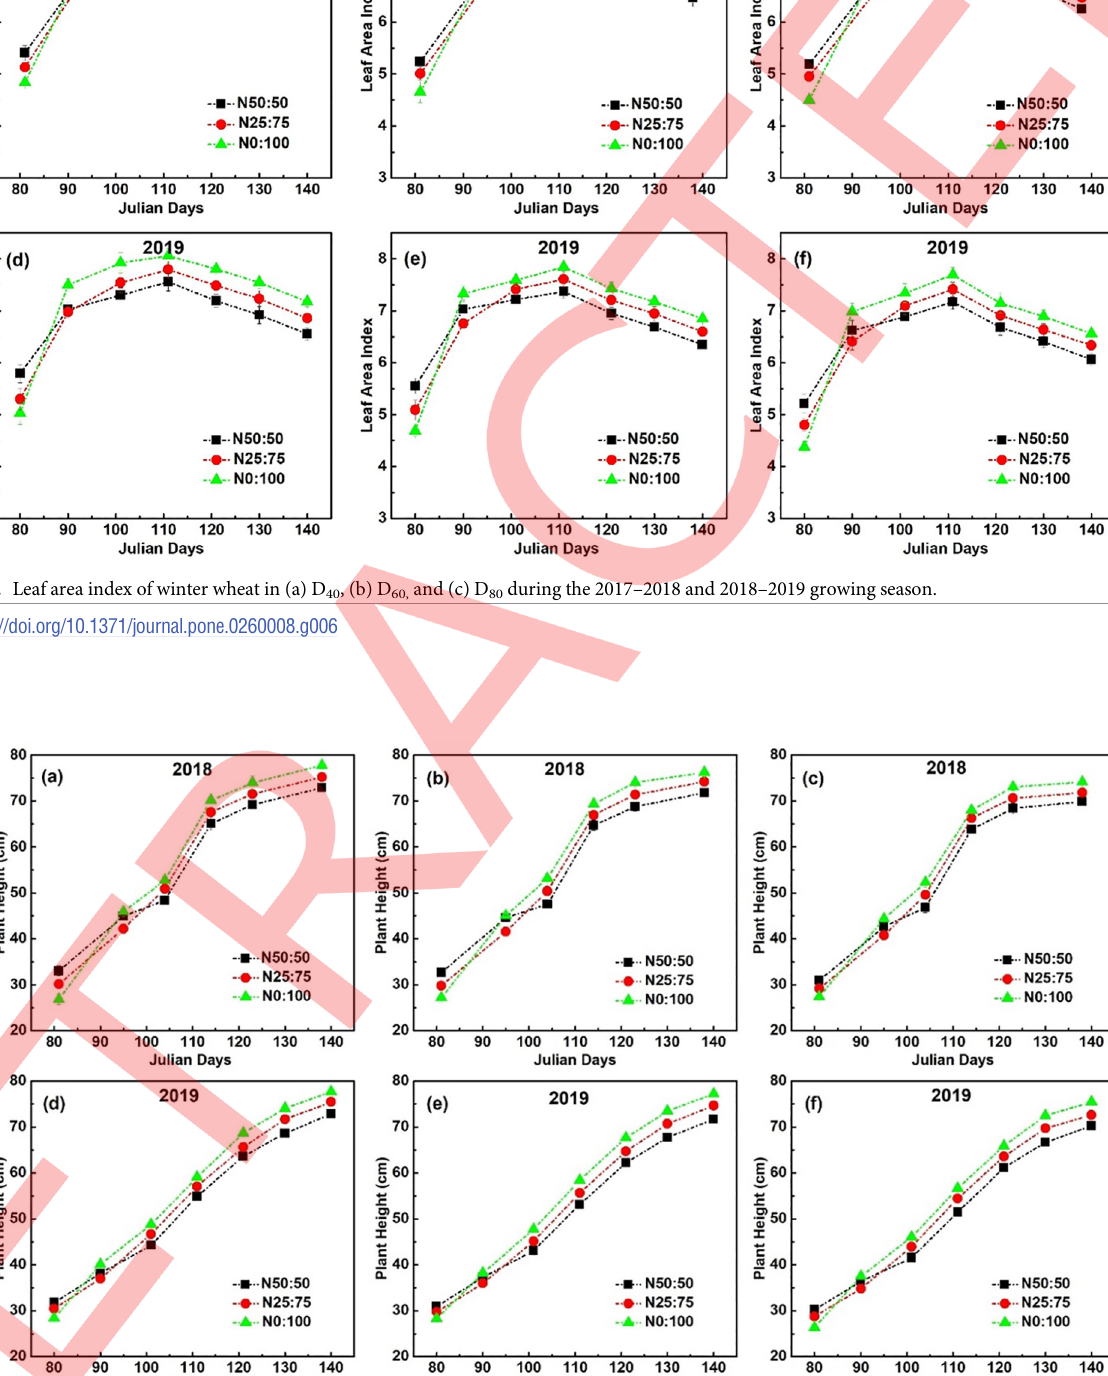
PLOS ONE | https://doi.org/10.1371/journal.pone.0260008 November12,